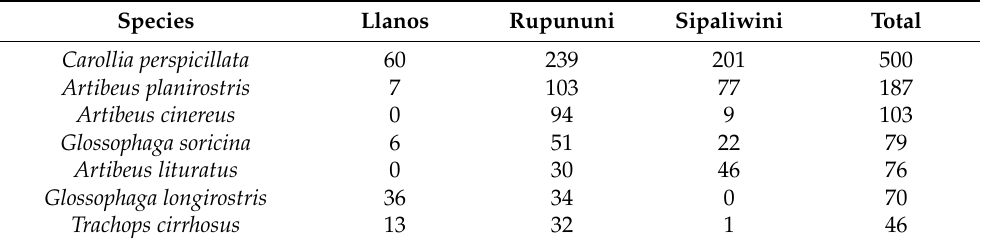
Table A1. Bat species documented in the Guianan savannas of northern South America and their relative abundance in the Llanos of Venezuela, Rupununi of Guyana, and Sipaliwini of